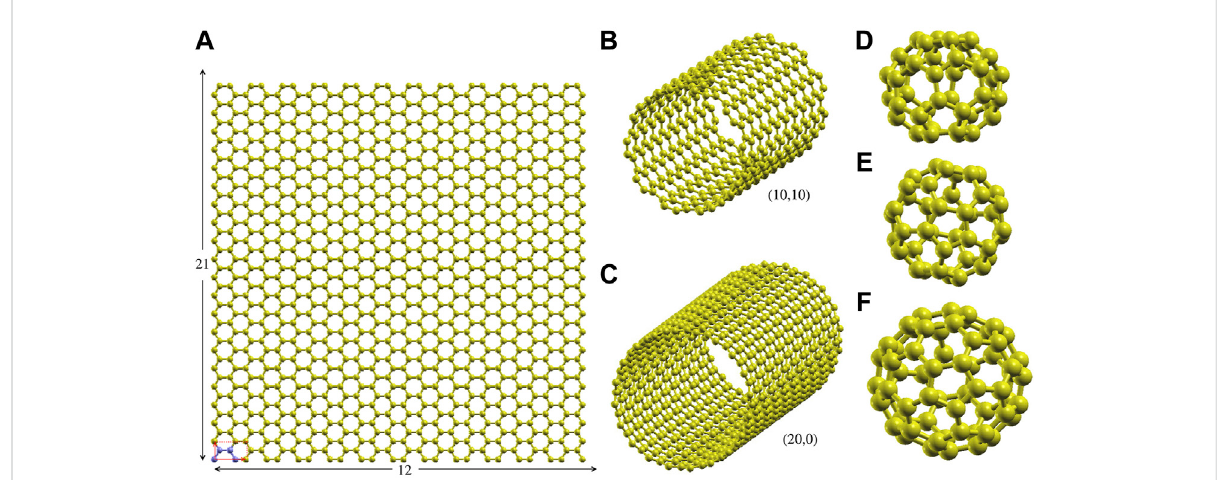
FIGURE 1 Supercells and representative structures. (A) The 1,008 atom 12 × 21 graphene rectangular supercell (size ≈ 51 . 12 Å × 51.65 Å). The 4-atom rectangular unit cell is shown in the left down corner of the structure (red rectangle). (B) and (C) The supercell of the (10.10) and (20.0) carbon nanotubes, as representatives of the ( n , n ) and ( n , 0) nanotubes. (D) , (E) The no. 38 and 39 C 40 fullerene isomers, as representatives of the 40 C 40 fullerene isomers. (F) The icosahedral C 60